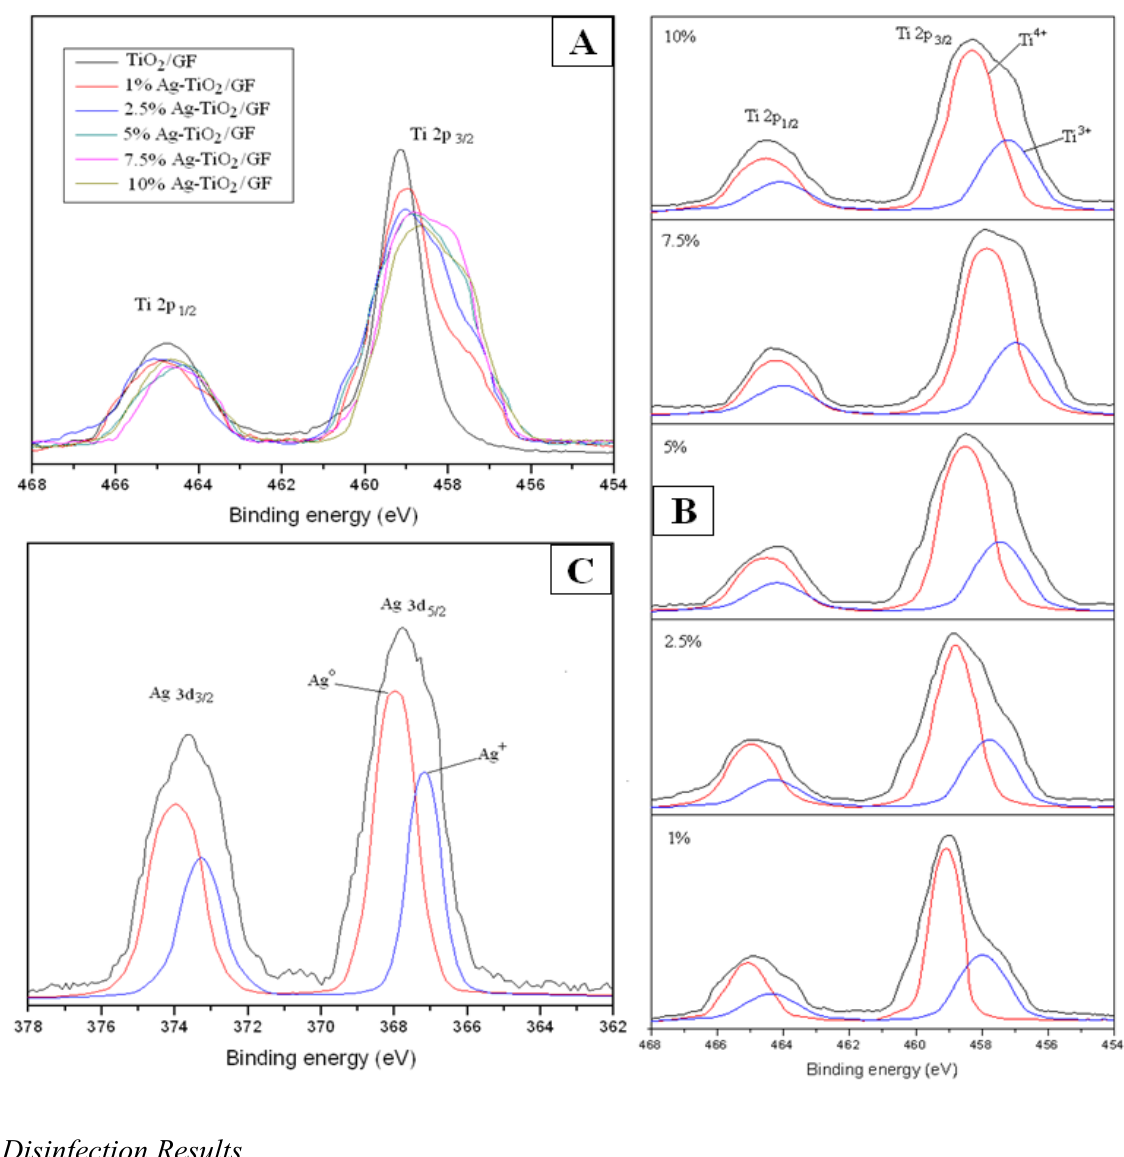
Figure 5. ( A ) XPS spectra of Ti 2p of TiO ( B ) High resolution XPS spectra of Ti 2p in X% Ag-TiO Ag-TiO 2